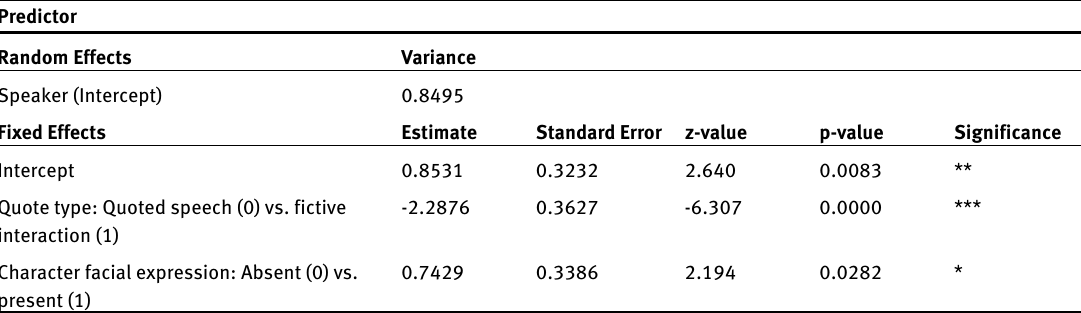
Table 7: The best generalized mixed-effects regression model for Quoted Dialogue sequences in the smaller dataset. Only predictors for the best-fit model are shown. Negative estimates indicate lower probability. Significance is indicated as follows: *** indicates p < 0.001, ** p < 0.01, * p < 0.05 and . p < 0.1.